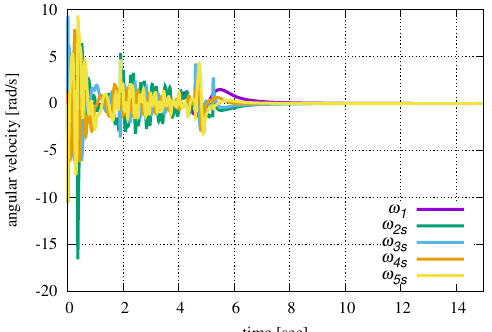
Figure 23. Case 2: Time variation of the angular